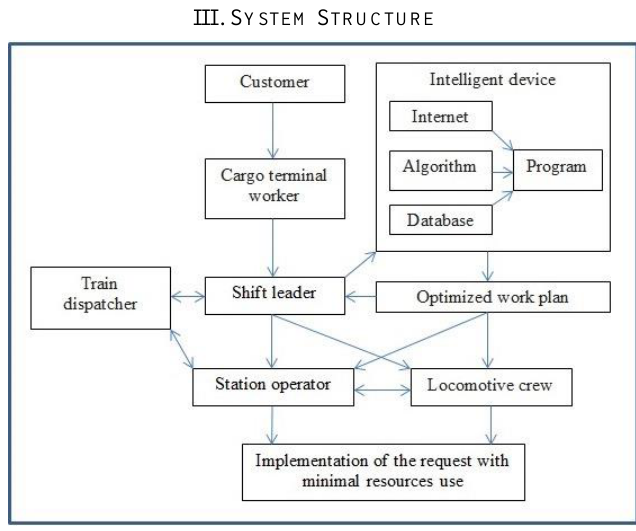
Fig. 3. System structure scheme.